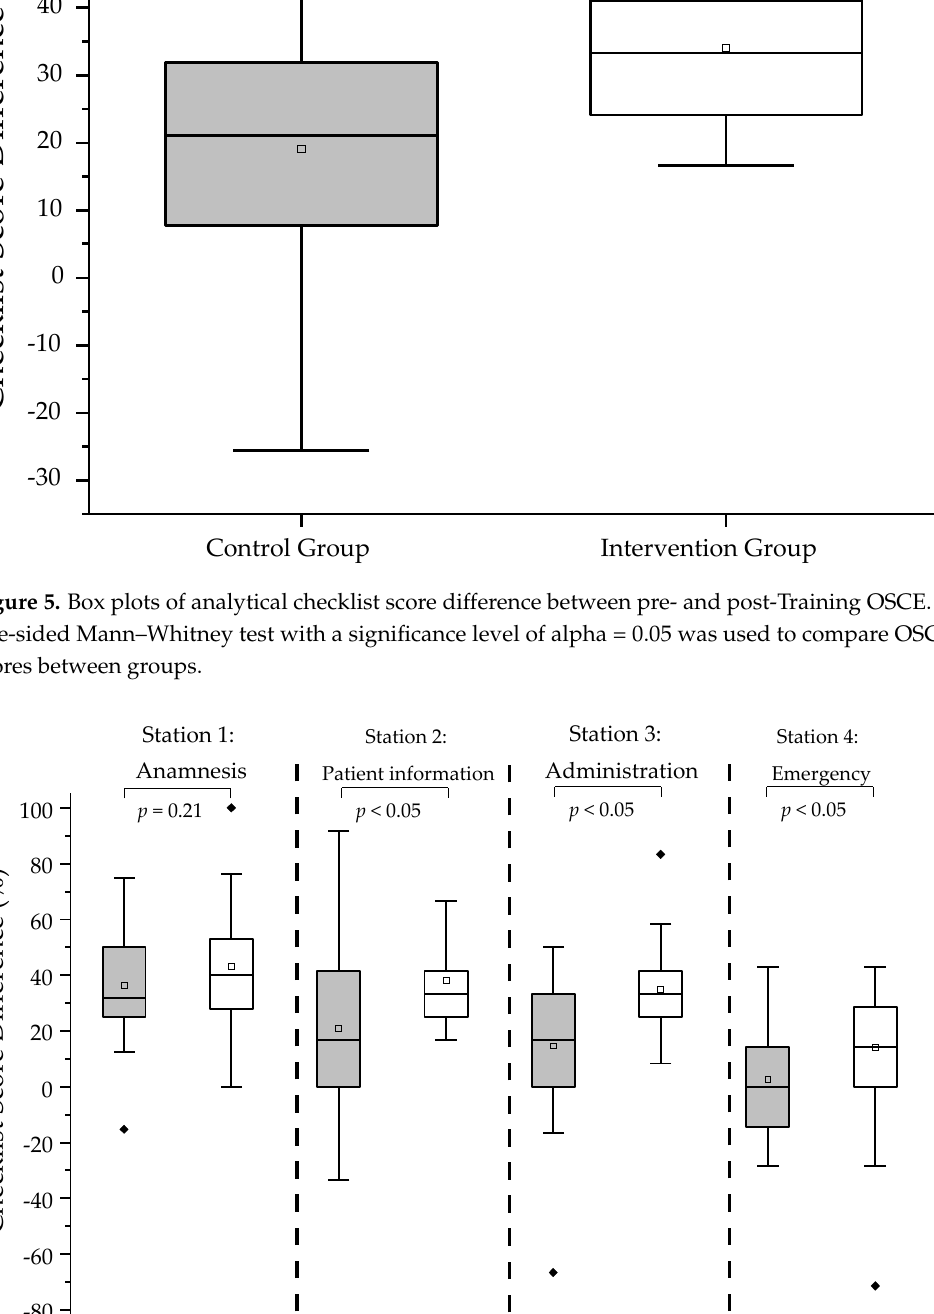
Figure 6. Box plots of analytical Checklist score differences for each station between pre- and post- training OSCE for respective groups. The black diamonds ( ♦ ) indicate the outliers. A one-sided Mann–Whitney test with a significance level of alpha = 0.05 was used to compare OSCE scores between groups.